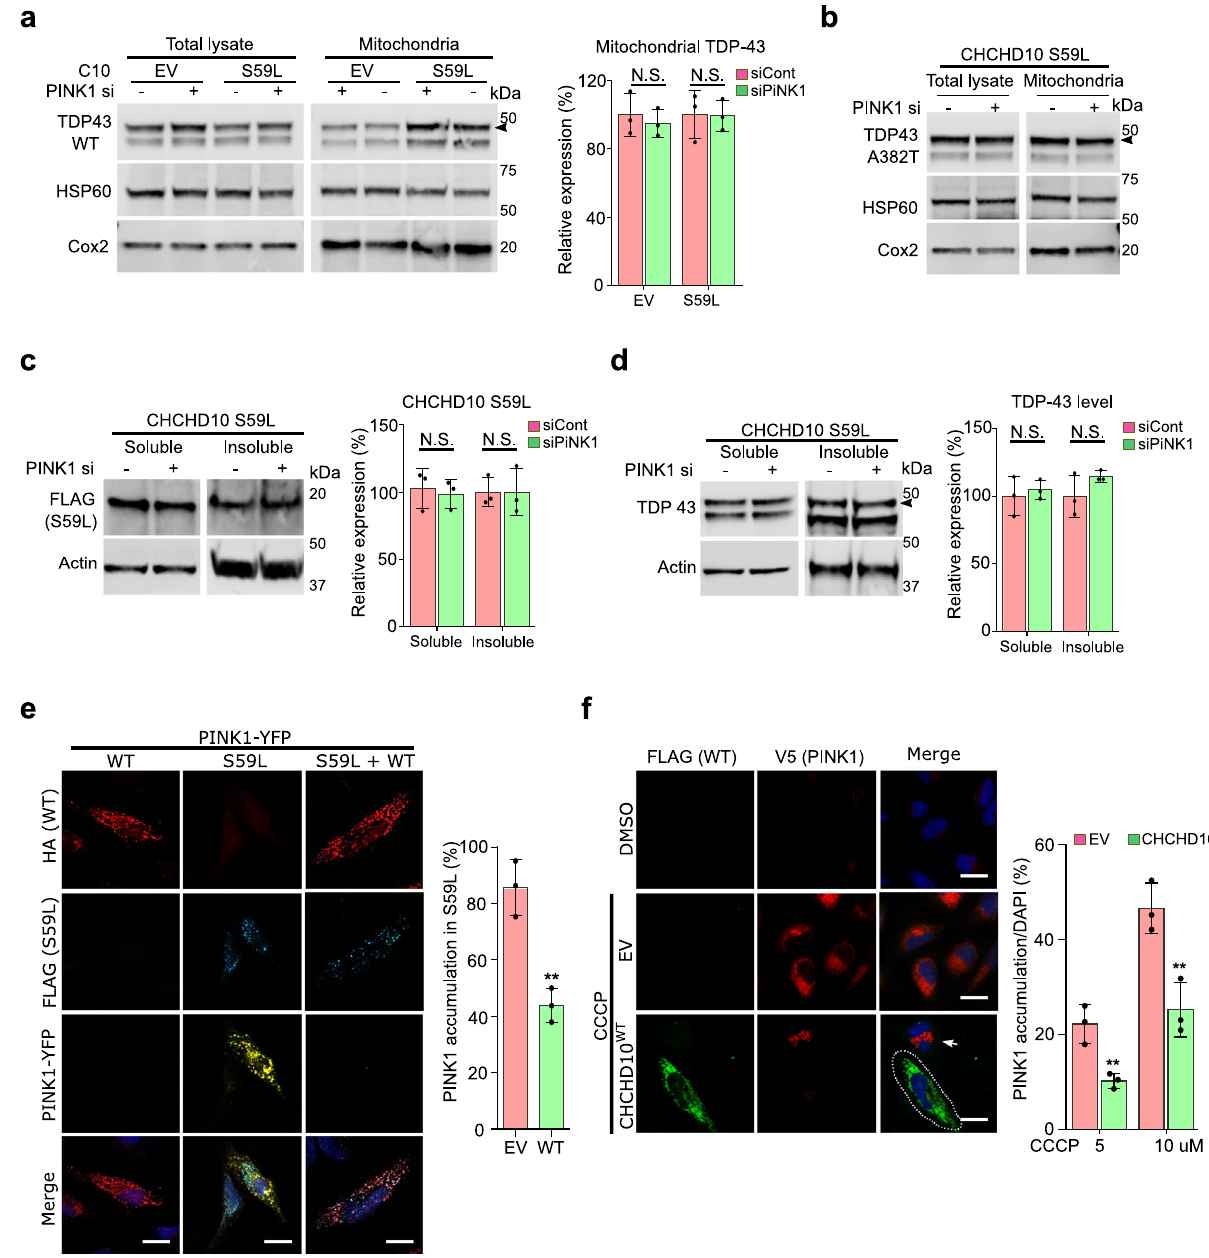
Fig. 8 Dominant toxicity of CHCHD10 S59L is mediated independently by TDP-43 and PINK1 signaling. a HeLa cells transfected with PINK1 siRNA were co-transfected with empty vector (EV) or FLAG-tagged CHCHD10 S59L and FLAG-tagged TARDBP WT . Fractionated mitochondria were analyzed with anti- TDP-43 (arrowhead indicates transfected TDP-43) or anti-HSP60 and anti-Cox2 (loading controls) antibodies. Data are shown as mean ± SD (two-sided t test, NS = not signi fi cant; n = 4 independent experiments). b HeLa cells transfected with PINK1 siRNA were co-transfected with empty vector (EV) or FLAG-tagged CHCHD10 S59L and TARDBP A382T . Fractionated mitochondria were analyzed with anti-TDP-43 (arrowhead indicates transfected TDP-43) or anti-HSP60 and anti-Cox2 (loading controls) antibodies. c HeLa cells transfected with PINK1 siRNA were transfected with FLAG-tagged CHCHD10 S59L . RIPA-soluble and insoluble fractions were analyzed with anti-FLAG and anti-actin (loading control) antibodies. Data are shown as mean ± SD (two-sided t test, NS = not signi fi cant; n = 3 independent experiments). d HeLa cells transfected with PINK1 siRNA were co-transfected with FLAG-tagged CHCHD10 S59L and TARDBP . RIPA-soluble and insoluble fractions were analyzed with anti-TDP-43 and anti-actin (loading control) antibodies. Data are shown as mean ± SD (two-sided t test, NS = not signi fi cant; n = 4 independent experiments). e HeLa cells transfected with PINK1-YFP , FLAG-tagged CHCHD10 S59L , and HA-tagged CHCHD10 WT or EV were visualized with anti-FLAG (blue) and anti-HA (red) antibodies and YFP (yellow) after 24 h of transfection. PINK1-positive cells with/without CHCHD10 WT in CHCHD10 S59L -expressing cells were counted (two-sided t test, ** p = 0.00335; n = 3 independent experiments, >50 cells for each group). Scale bar = 20 μ m. f HeLa PINK1-V5-His cells transfected with EV or CHCHD10 WT were treated with CCCP (10 μ M) for 6 h. Cells were immunostained with anti-FLAG (green) and anti-V5 (red) antibodies to visualize CHCHD10 and PINK1, respectively. Arrow indicates PINK1 accumulated in a non-transfected cell neighboring a CHCHD10 -transfected cell (white dashed line). The percentage of PINK1- positive cells from the empty vector (EV) or CHCHD10 WT -transfected cells were calculated after 5 or 10 μ M CCCP treatment for 6 h. Data are shown as mean ± SD (two-sided t test, ** p = 0.009055 for 5 μ M and 0.009203 for 10 μ M CCCP treatment; n = 3 independent experiments, >200 cells for each group). Scale bar = 20 μ